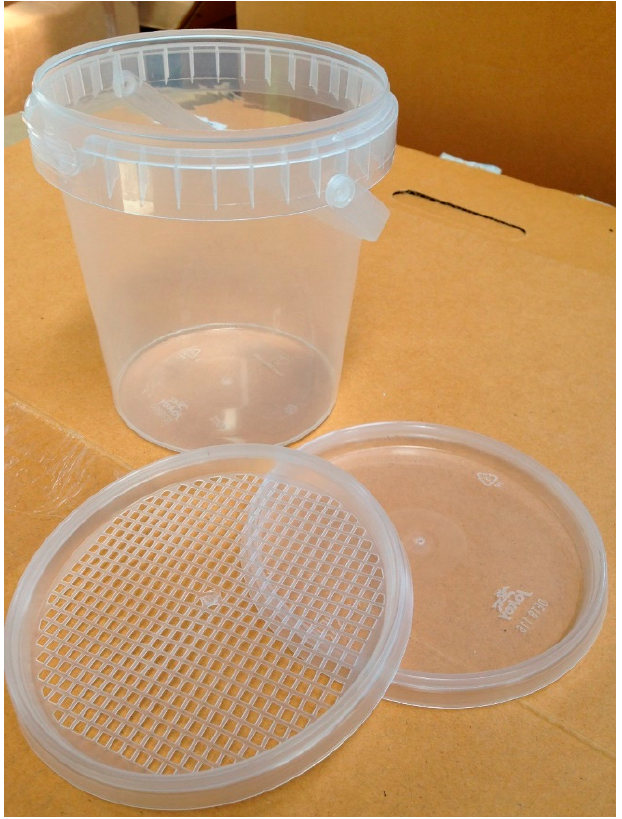
Figure 1. Jar provided with a mesh to separate powdered sugar and mites from adult